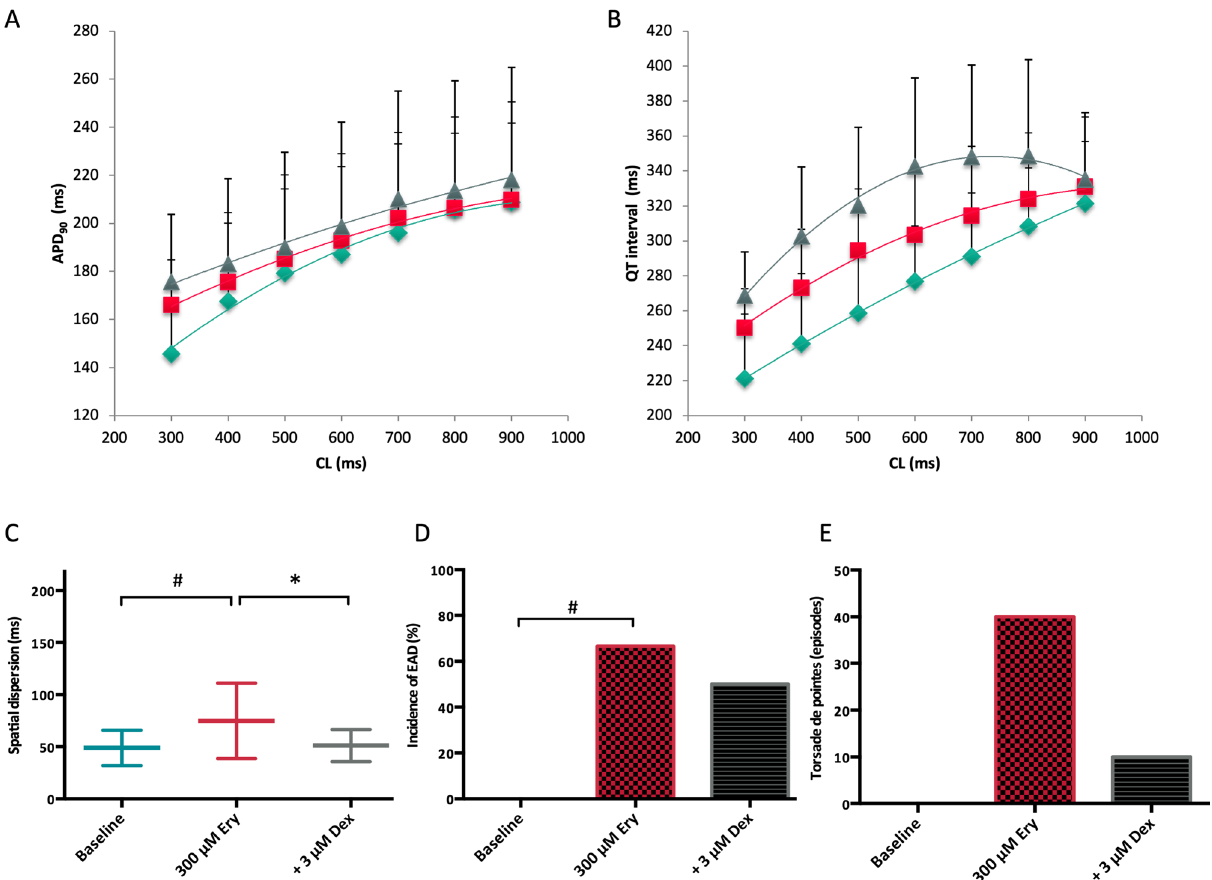
Figure 4. ( A , B ) Cycle-length dependent action potential durations (APD 90 ) and QT interval under baseline conditions (◆), after infusion of 300 µM erythromycin ( ■ ) and after additional treatment with 3 µM dexmedetomidine ( ▲ ). ( C ) Impact of erythromycin (Ery) and dexmedetomidine (Dex) on spatial dispersion of repolarization. ( D ) Occurrence of early afterdepolarizations (EAD) after administration of erythromycin and after additional treatment with dexmedetomidine. ( E ) Incidence of torsade de pointes under baseline conditions, with erythromycin and with the combination of erythromycin and dexmedetomidine (# = p < 0.05 compared to baseline conditions; * = p < 0.05 compared to sole erythromycin